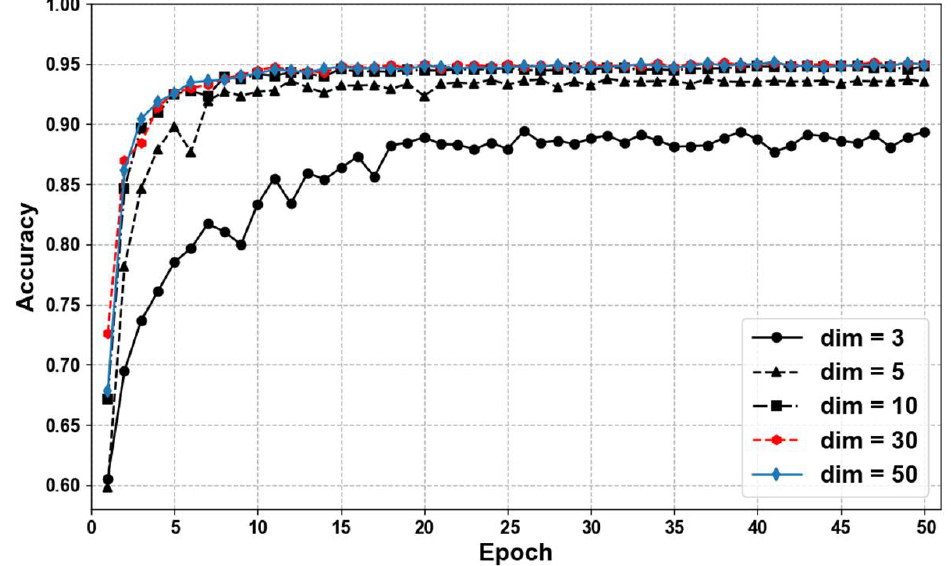
Figure 7. Accuracy of Epoch with different dimensions of FastText model (-ngrams = 2; learning rate = 0.01; neg = 10).